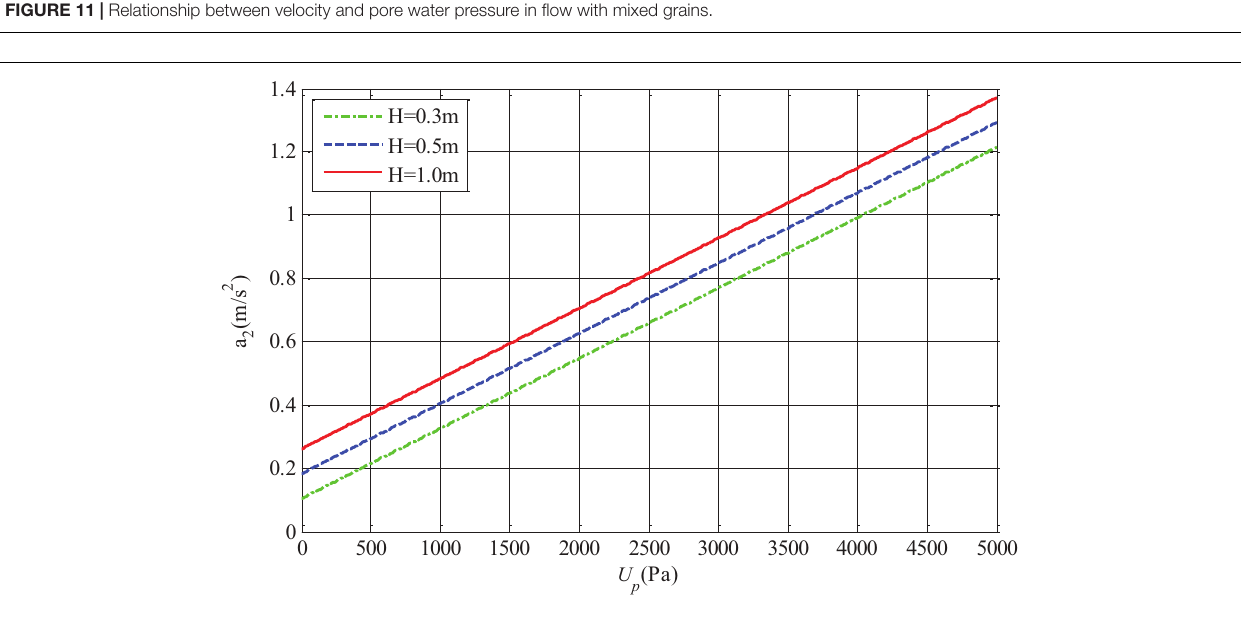
FIGURE 11 | Relationship between velocity and pore water pressure in flow with mixed grains.